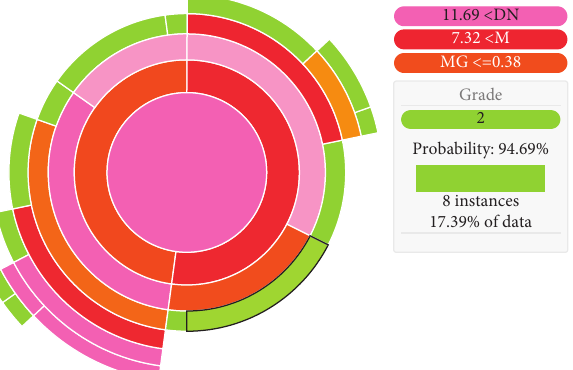
Figure 9: Variable distribution of the decision tree model from the perspective of the sunburst chart.